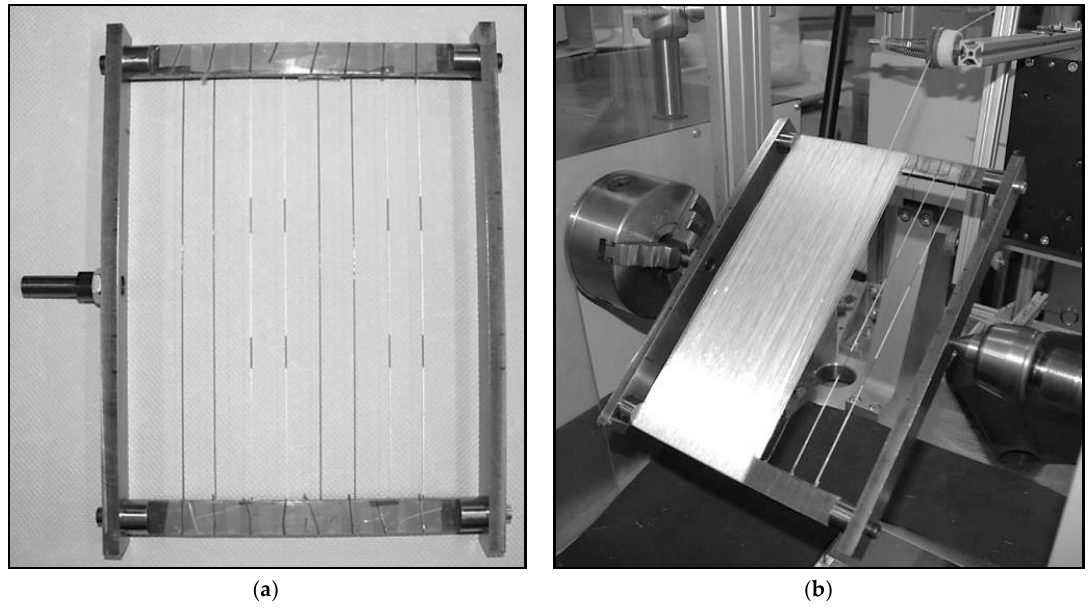
Figure 3. Sensor fiber placement in a rectangular mandrel (with and without silver paint pattern for improved conductivity) by adhesive tape ( a ) during the GF/PP unidirectional composites winding process ( b ).